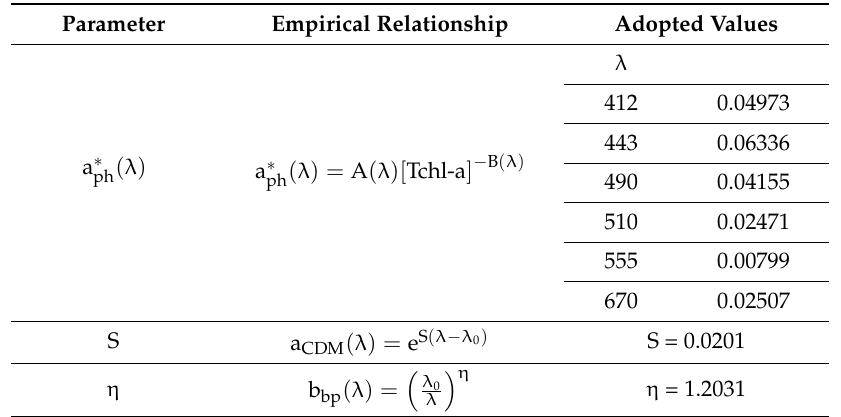
Table 6. Regression indices and statistical indicators computed based on the previous chl-a match-up analyses (Figure 11).